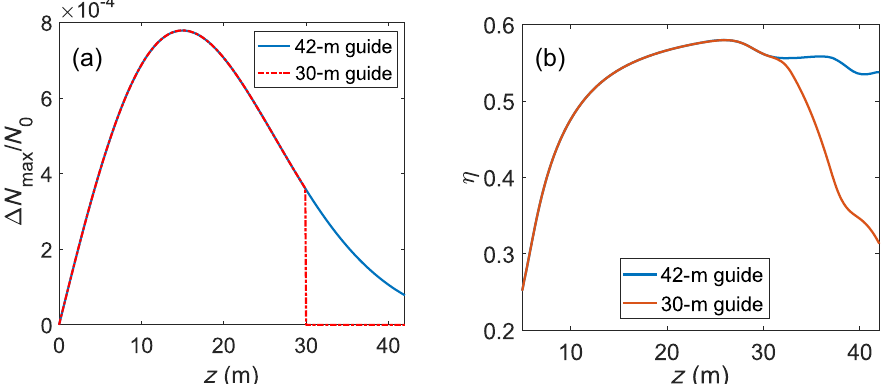
FIG. 9. BPM simulation of guiding efficiency in two lengths of an 18-filament-induced waveguide. (a) Prescribed density-hole depth vs z [scaled and stretched in length from Fig. 3(b)]. For the 30-m guide, the hole depth (and therefore, the waveguide cladding depth) is set to zero for z > 30 m. (b) Guiding efficiency η ð z Þ for the two guide lengths.